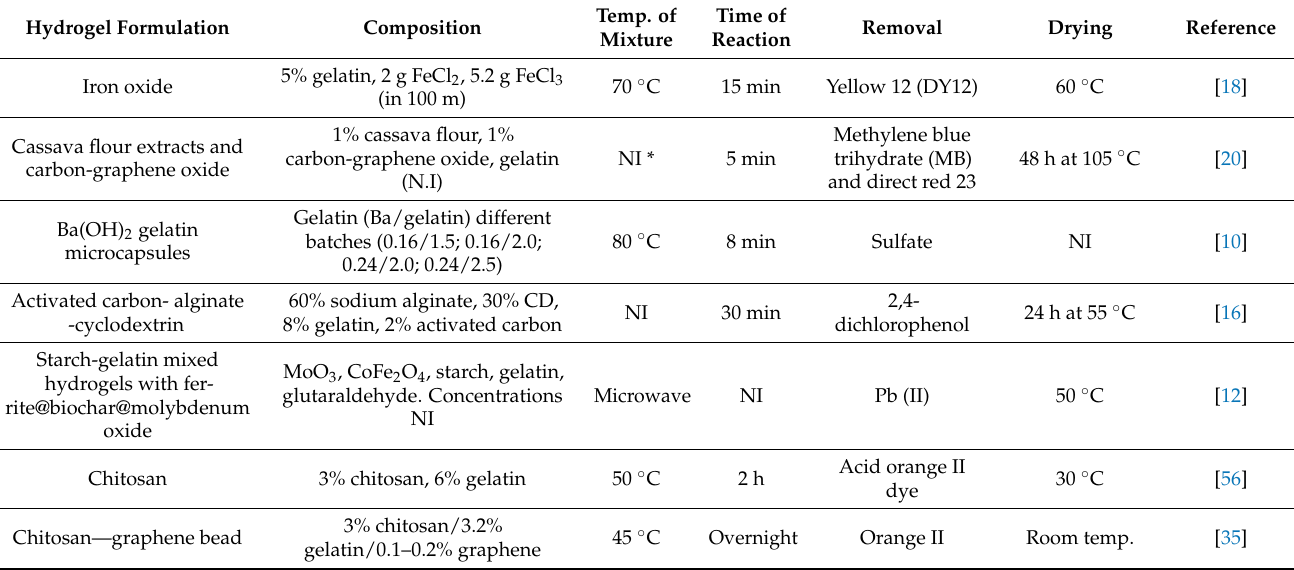
Table 2. Formulations of different gelatin-based hydrogels for remediation